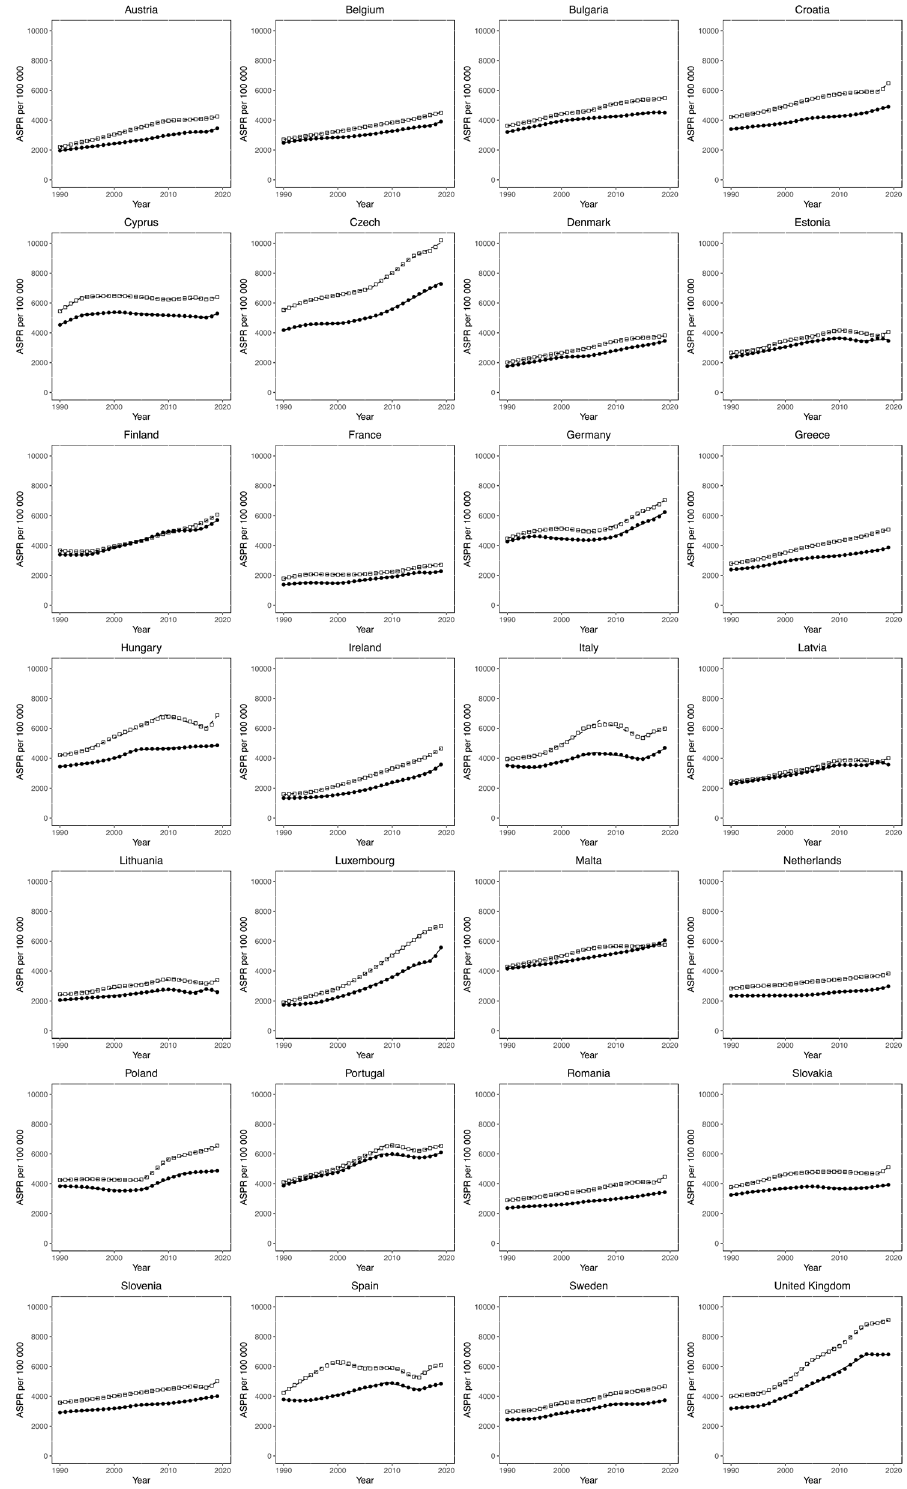
Figure 3. Trends in T2DM prevalence. Trends in age-standardised prevalence rates (ASPRs) per 100,000 population for type 2 diabetes mellitus (T2DM) in all European Union (EU) countries and the UK from 1990 to 2019. Open squares represent males, filled circles represent